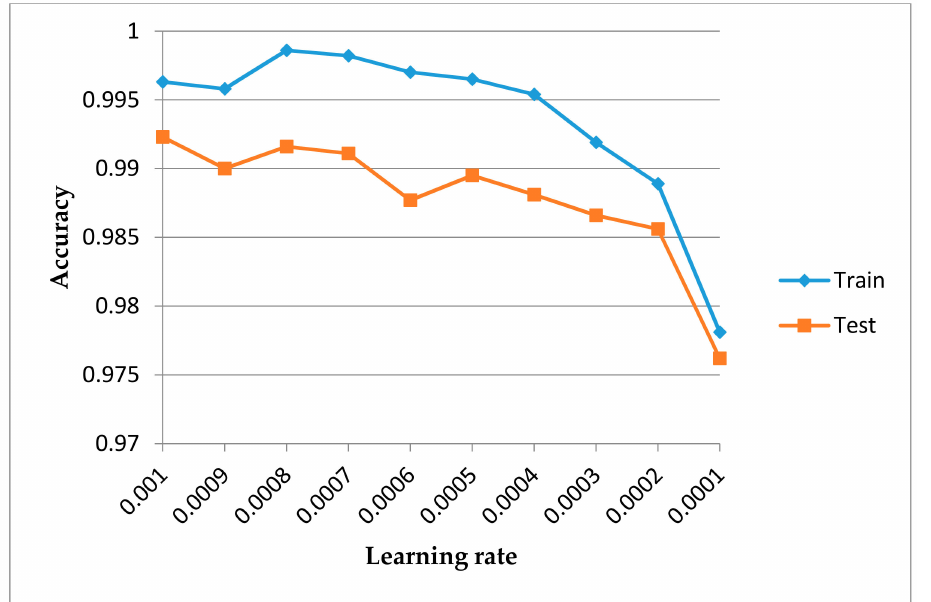
Figure 9. Effects of changing the ST-CNN model learning